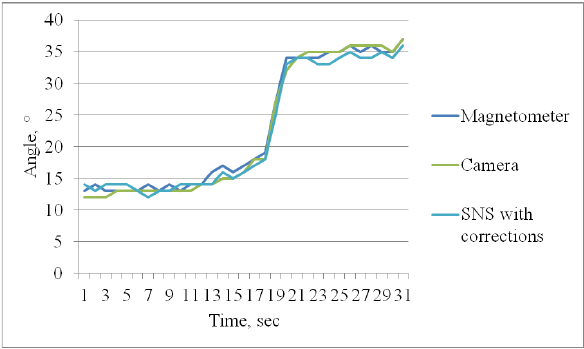
Fig. 3. The chart of a dichotomizing fragment of a tree of process of search of refusal in the accelerometer and uncertainty of AVS